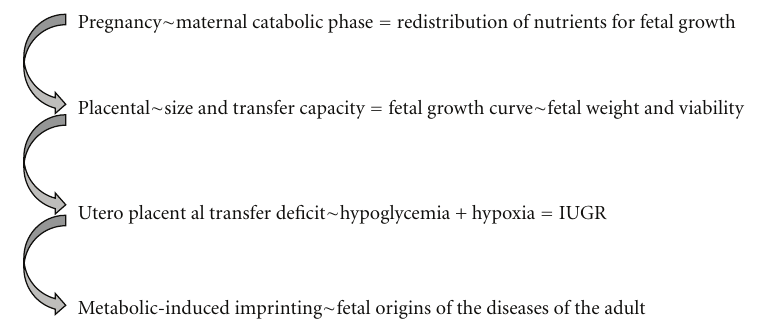
Figure 3: The intrauterine life is very delicate balance between fetal growth and placental transport capacity which depends on the mother’s vascular capacity. If the placenta is not fully developed (anomalous insertion, second wave invasion incomplete, or other maternal morbidity like long-term diabetes, hypertension or other related disease with vasculopathy), decreased blood flow through the umbilical cord will generate several survival responses in the fetus, all with the aim of reaching a viable weight and enough lung maturation to survive outside the womb. The mechanisms are energy-savers and try to protect the brain from damage. This metabolically induced imprinting lasts very well into adulthood, being the key feature in the development of chronic diseases like Obesity, Type 2 diabetes, Stroke, Cardiovascular disease, among others.